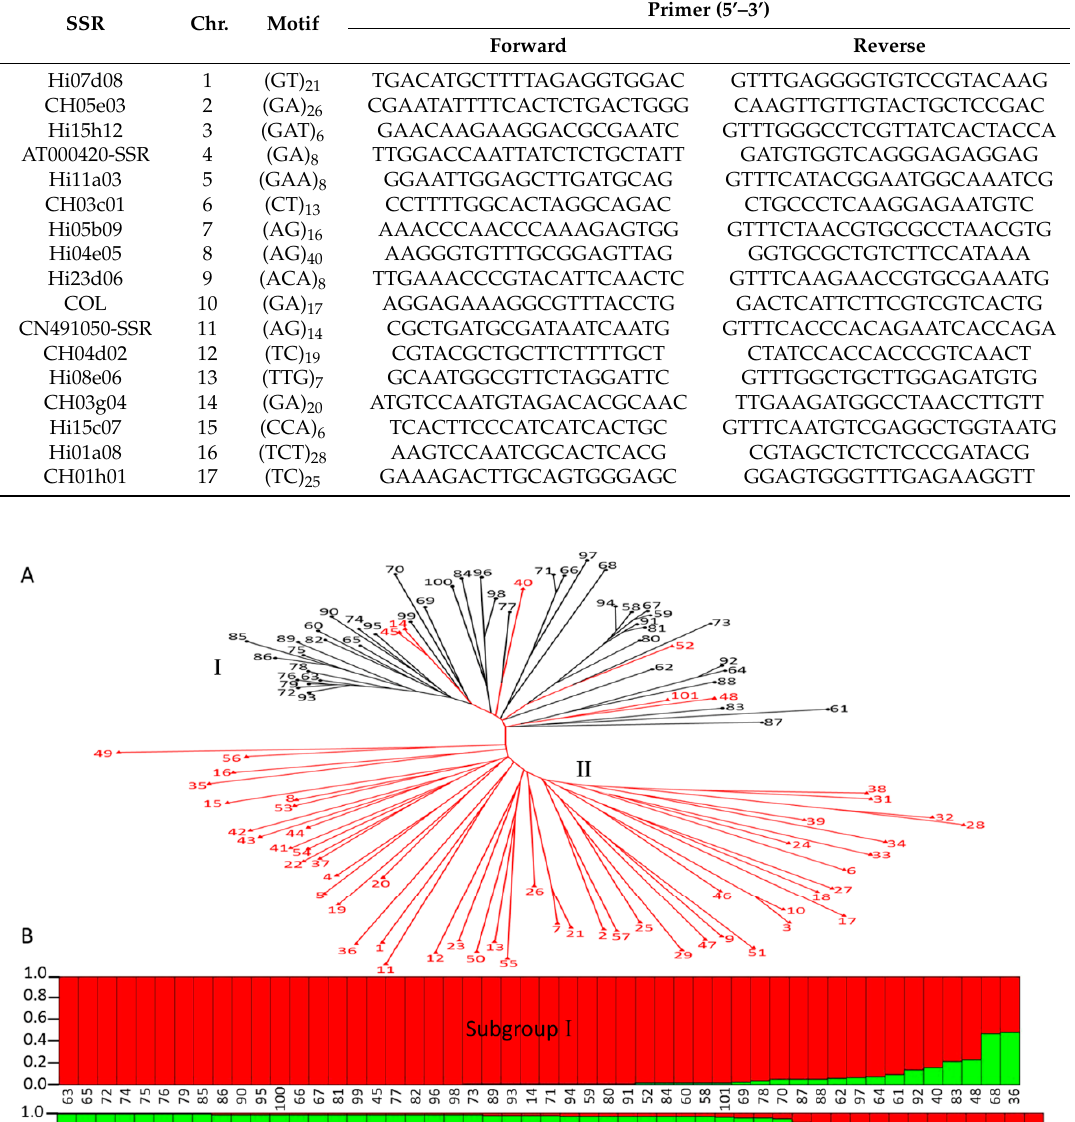
Table 1. Simple sequence repeat (SSR) markers used for characterization of apple germ plasm.